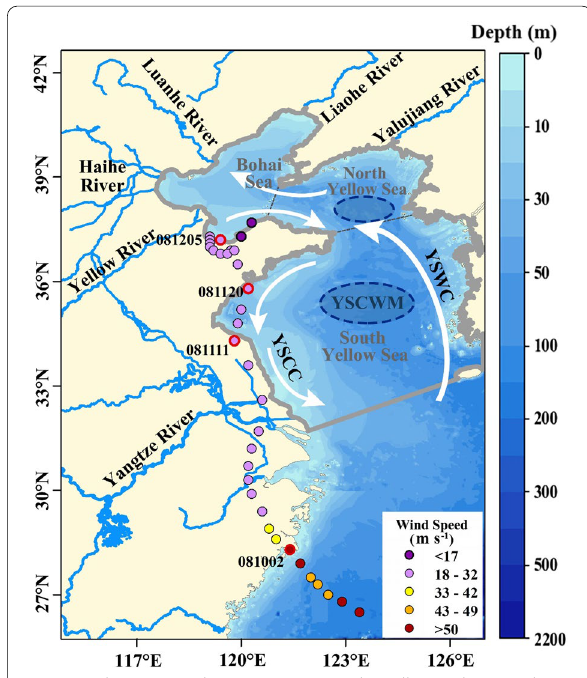
Fig. 1 Bathymetry and current system in the Yellow‑Bohai Sea, the main inflow rivers, and the track of Typhoon Lekima (during 4–13th August, 2019). The white lines with arrows denote the Yellow Sea Warm Current (YSWC) and Yellow Sea Coastal Current (YSCC), and blue oval circles the Yellow Sea Cold Water Mass (YSCWM). The track and maximum sustained wind speeds during the Typhoon Lekima event were obtained from China Meteorological Administration (http:// www. typho on. org. cn). Red circles denote typhoon centers at a specific time (Beijing local time, UTC 8). The bathymetry data are + from ETOPO1 Global Relief Model (Amante and Eakins 2009). Current system is modified from Yu et al. (2021). River routing system is from Resource and Environment Science and Data Center of Chinese Academic of Science (http:// www. resdc. cn/ data. aspx?